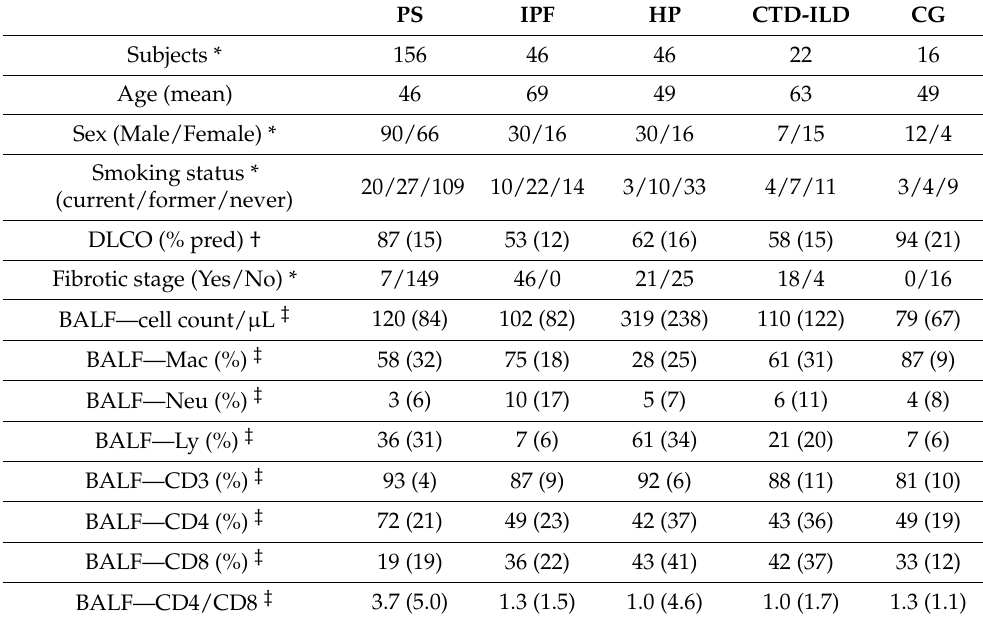
Table 1. Characteristics of the study